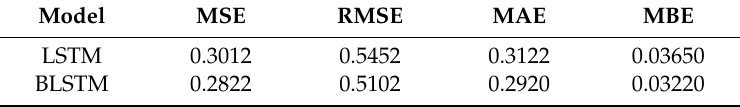
Table 5. Analysis of BLSTM with LSTM for forecasting time series energy data.